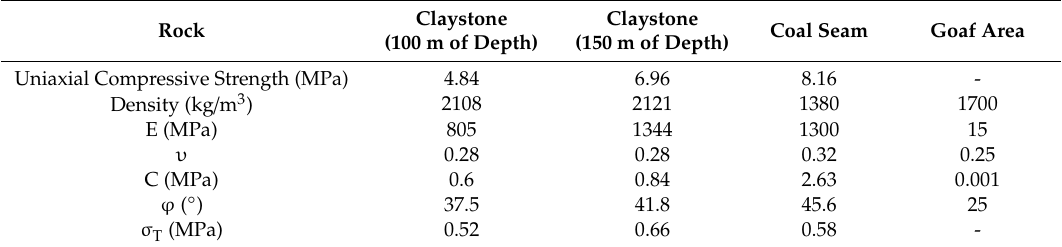
Table 1. Mechanical properties of the rock.